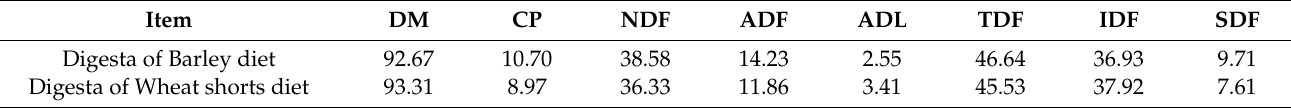
Table 1. Chemical composition of feed ingredients (air-dried